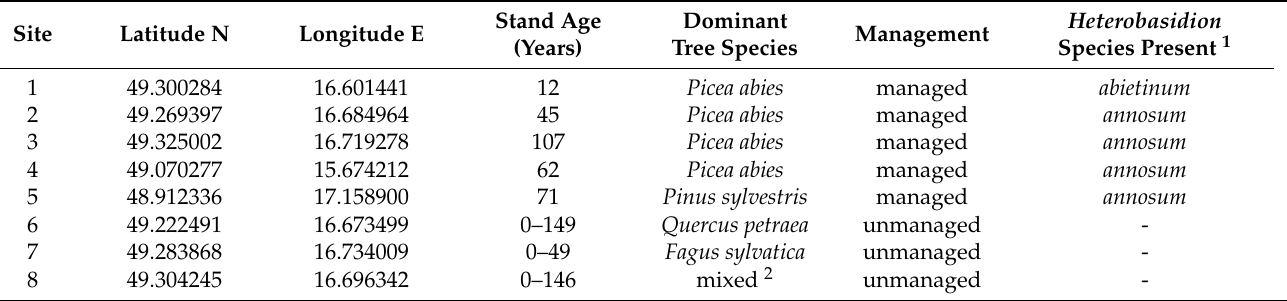
Table 1. Main features of experimental